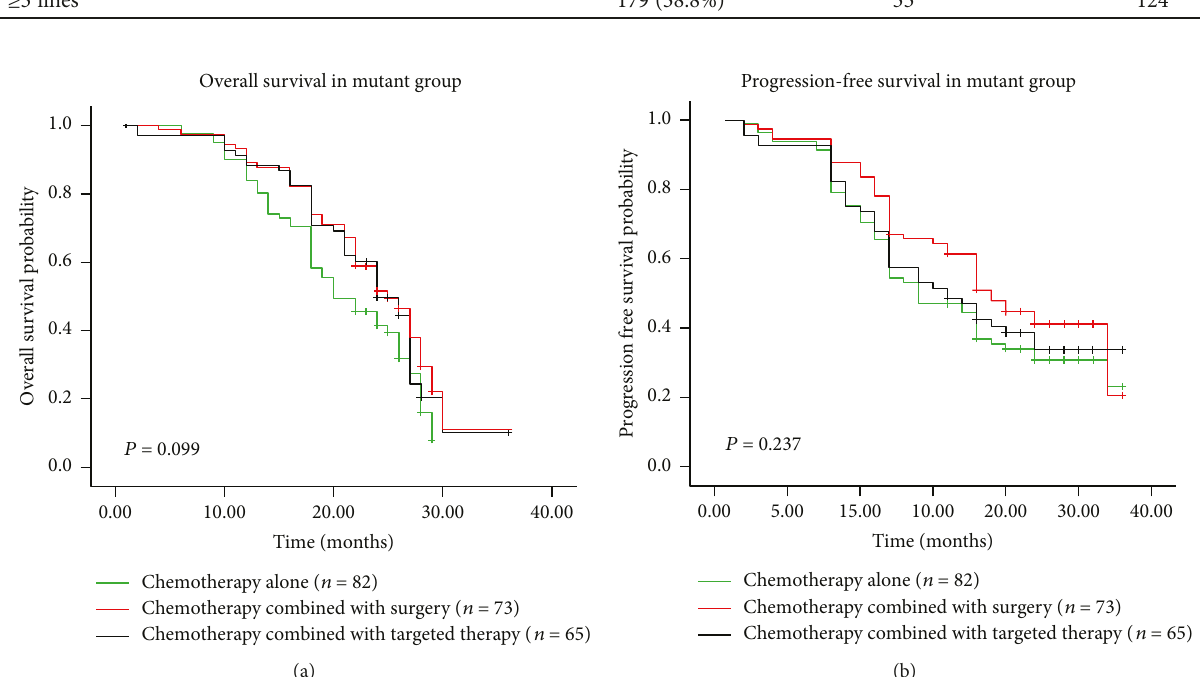
Figure 5: Kaplan-Meier survival curves of mutant group strati fi ed according to treatment regimens. (a) OS and (b) PFS of patients treated with di ff erent regimens. OS: overall survival; PFS: progression-free